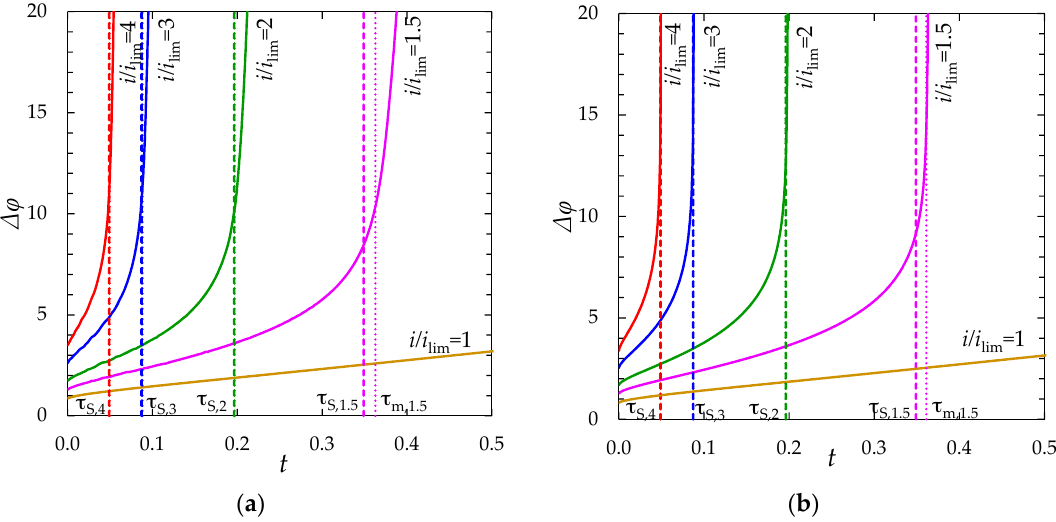
Figure 3. Chronopotentiograms (solid lines) computed for a CEM in a NaCl solution at ε = 3 × 10 − 7 ( a ) and ε = 1.6 × 10 − 10 ( b ) at the different current densities i/i lim = 1; 1.5; 2; 3; 4. The dashed lines show the transition times, τ S , calculated using the Sand equation, Equation (18), at the current density indicated near the curve: τ S ,1.5 = 0.349, τ S,2 = 0.196, τ S,3 = 0.087, τ S,4 = 0.049. The dotted lines show the transition times τ m,1.5 = 0.363 at ε = 3 × 10 − 7 and τ m,1.5 = 0.361 at ε = 1.6 × 10 − 10 ; the difference between τ m and τ S becomes negligible at i/i lim ≥ 2. Curves ( a ) are computed using the “primary” model, curves ( b ), using the “simplified” model.